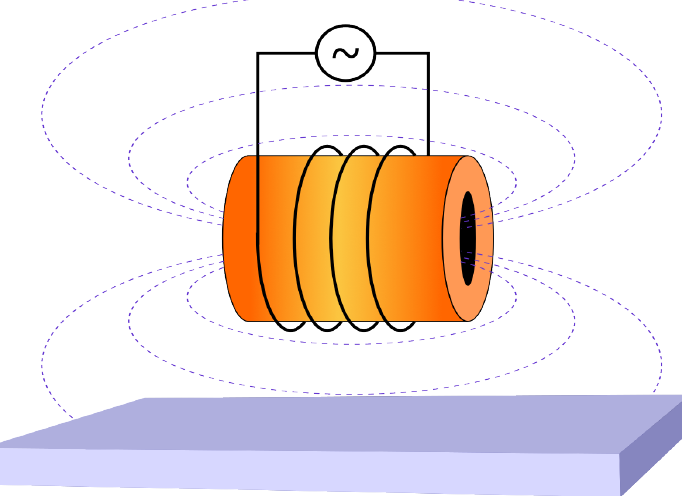
Figure 1. Induction heating using induced